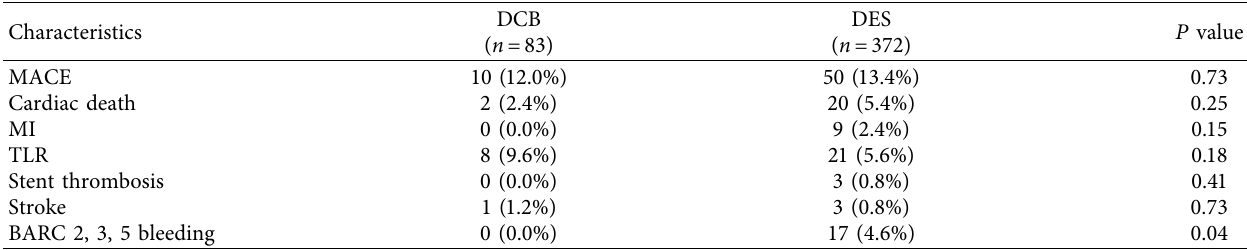
Table 4: Clinical outcomes at one